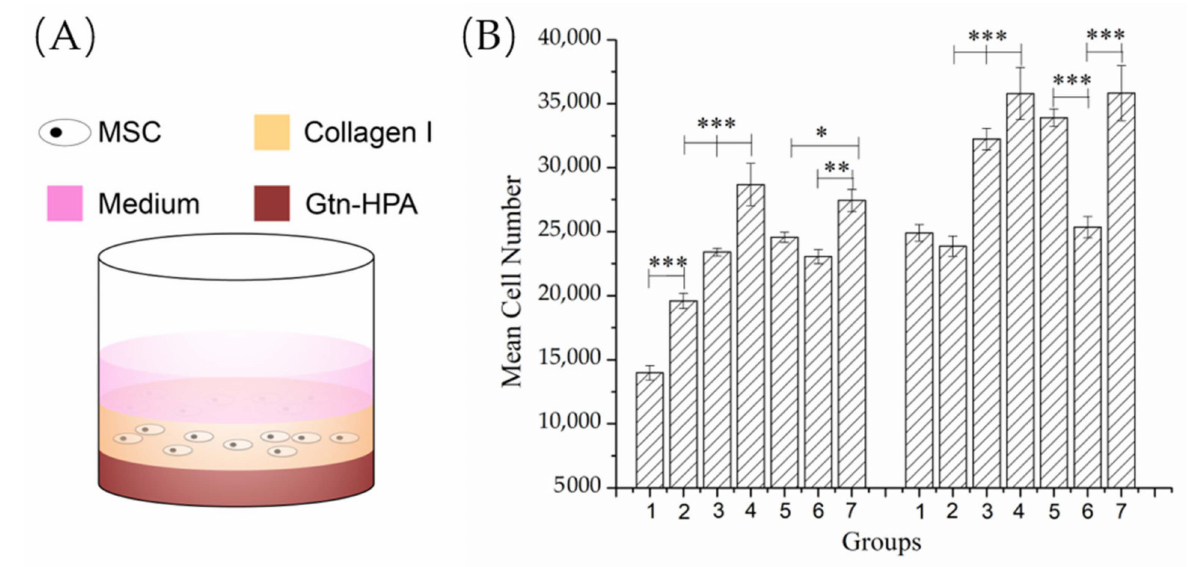
Figure 6. ( A ) Bilayer proliferation model. ( B ) Proliferated cell numbers on days 4 and 7. Groups are (1). Blank; (2) PCN for PDGF-BB; (3) soluble PDGF-BB; (4) PDGF-BB/PCNs; (5) PCNs for SDF-1 α ; (6) soluble SDF-1 α ; (7) SDF-1 α /PCNs (* p < 0.05; ** p < 0.01; *** p <